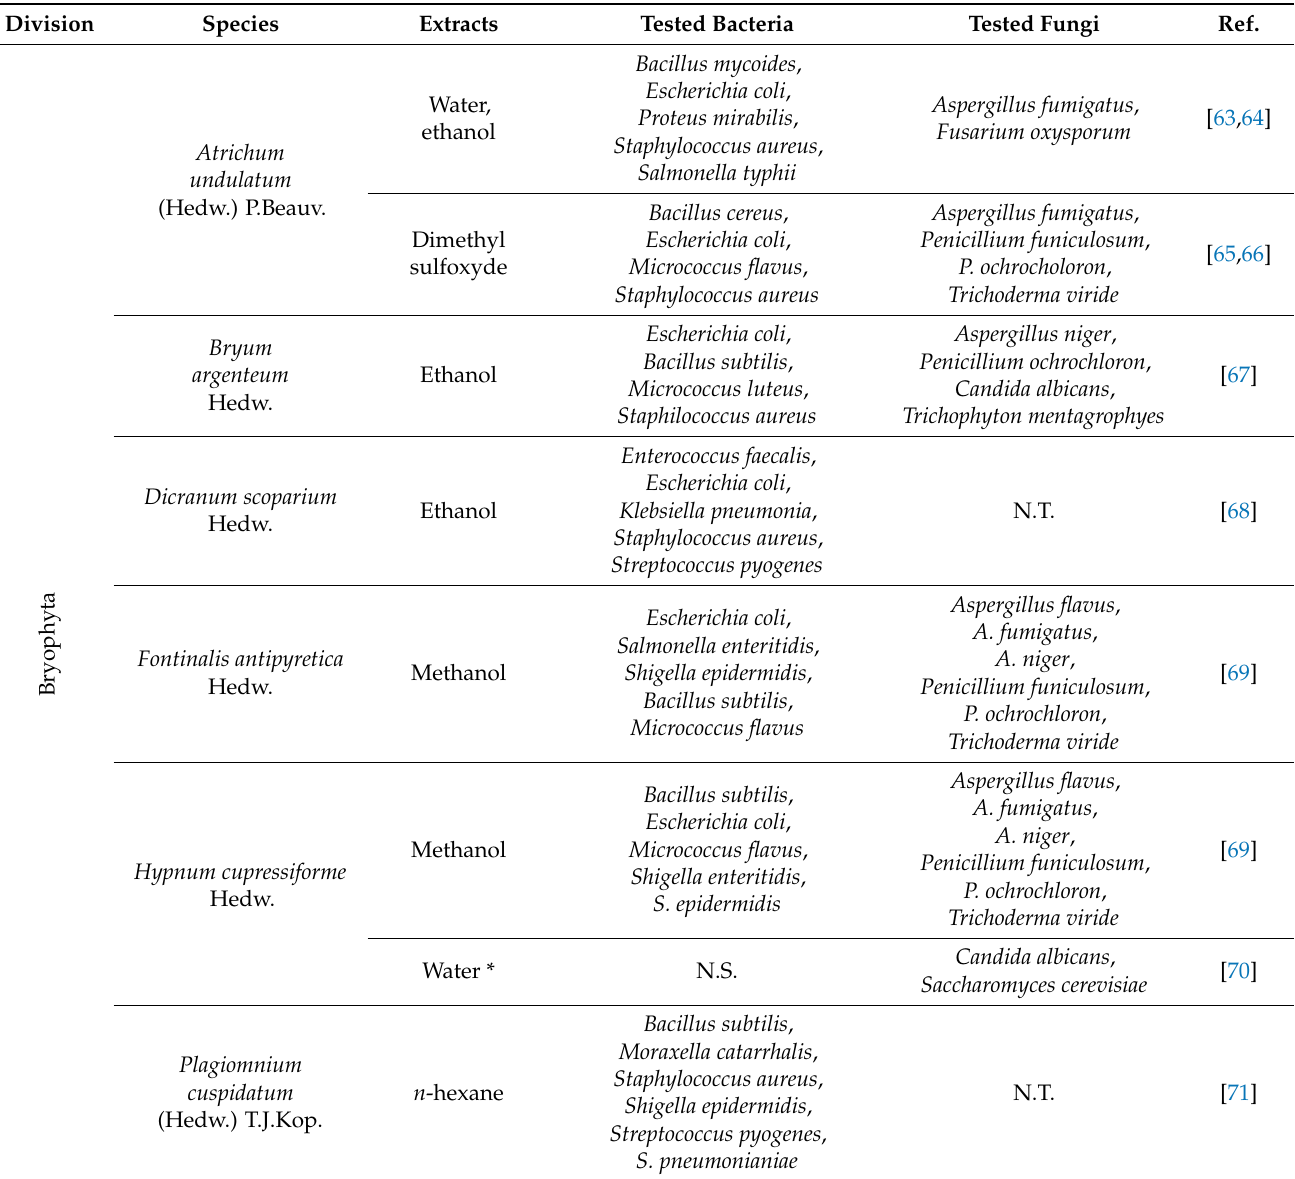
Table 3. Antimicrobial activities of some bryophyte